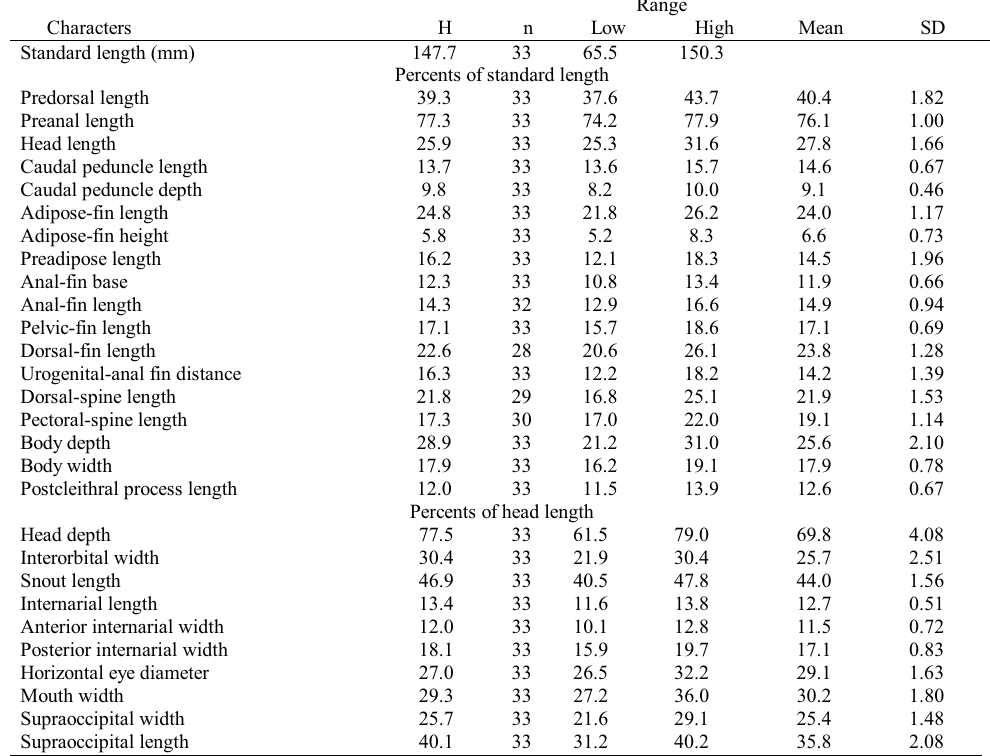
Table 1. Morphometric data of Pimelodus pohli , new species (H = Holotype, MCP 38775, 1 of MCP 37339, 1 of MCP 14061, 3 of MCP 16668, 8 of MCP 37078, 4 of MCP 38776; 6 of MZUSP 39320, 3 of MCP 16661, 3 of MCP 16671, 2 of MZUSP 24704, 1 of MZUSP 28782), SD = standard deviation. Range includes the holotype.